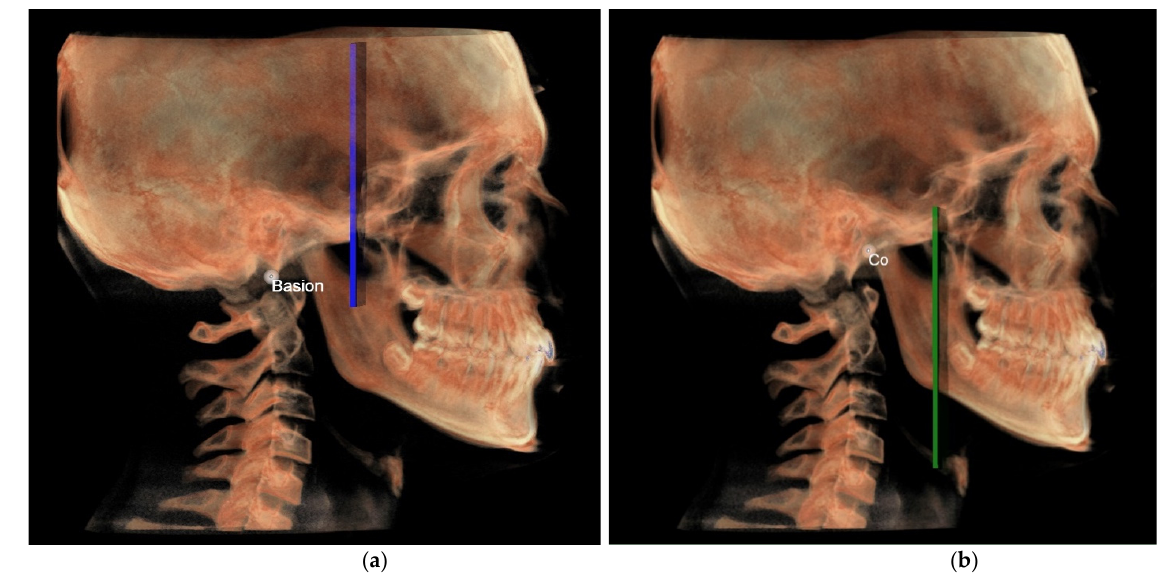
Figure 10. ( a ) Middle cranial fossa (MCF) in 3D analysis; ( b ) ramus in 3D analysis.